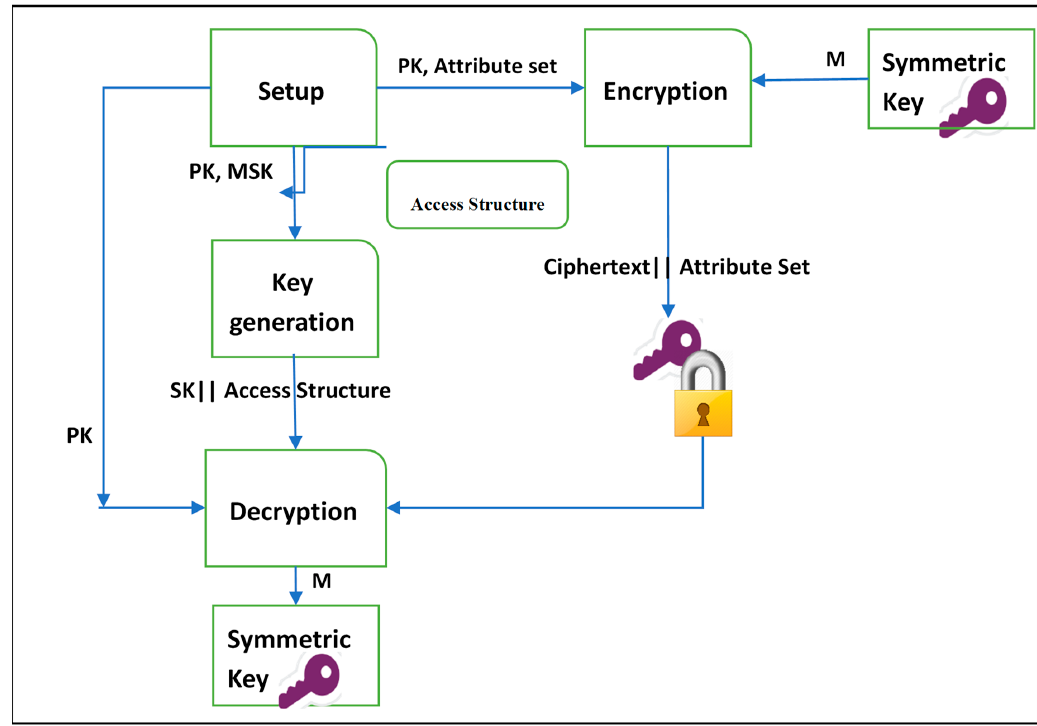
Figure 2. The procedure of key policy attribute-based encryption (KP-ABE). Sensors 2019 , 19 , 1695 Figure 2: The procedure of key policy attribute ‐ based encryption (KP ‐ ABE).